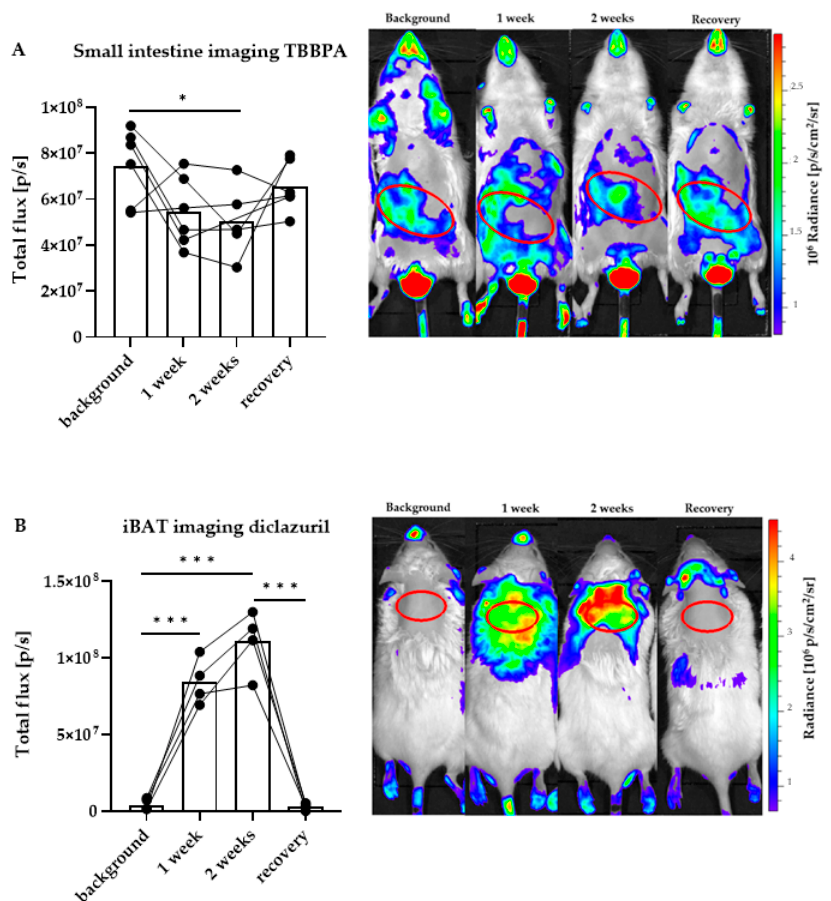
Figure 3. Quantitation of local thyroid hormone action after disruptor treatment with in vivo imaging. Representative images and quantification in male THAI mice treated orally for two weeks with 150 mg/bwkg/day of TBBPA in corn oil containing 2% Et-OH, or 10 mg/bwkg/day of diclazuril as a saline suspension, followed by one week of recovery; ( A ) ventral in vivo imaging of TBBPA treatment; ( B ) dorsal in vivo imaging of diclazuril treatment. n = 4–6 mice/group; figure shows Tukey Box Plots, α = 0.05; *: p < 0.05, ***: p <